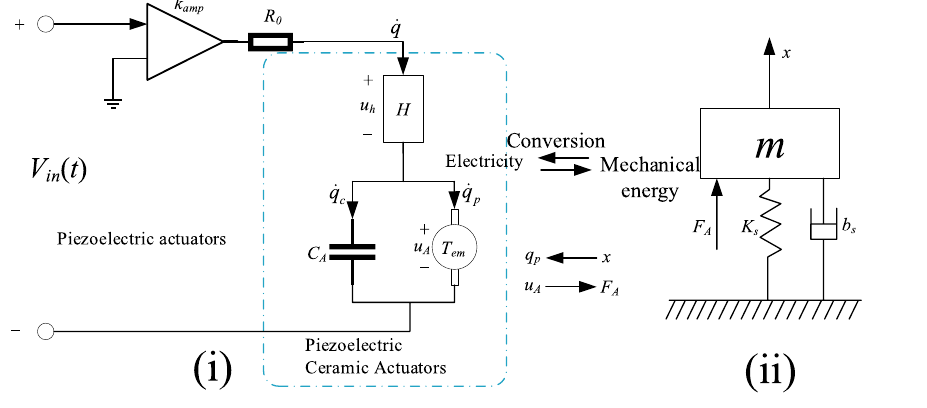
Figure 1. Schematic diagram of the piezoelectric positioning